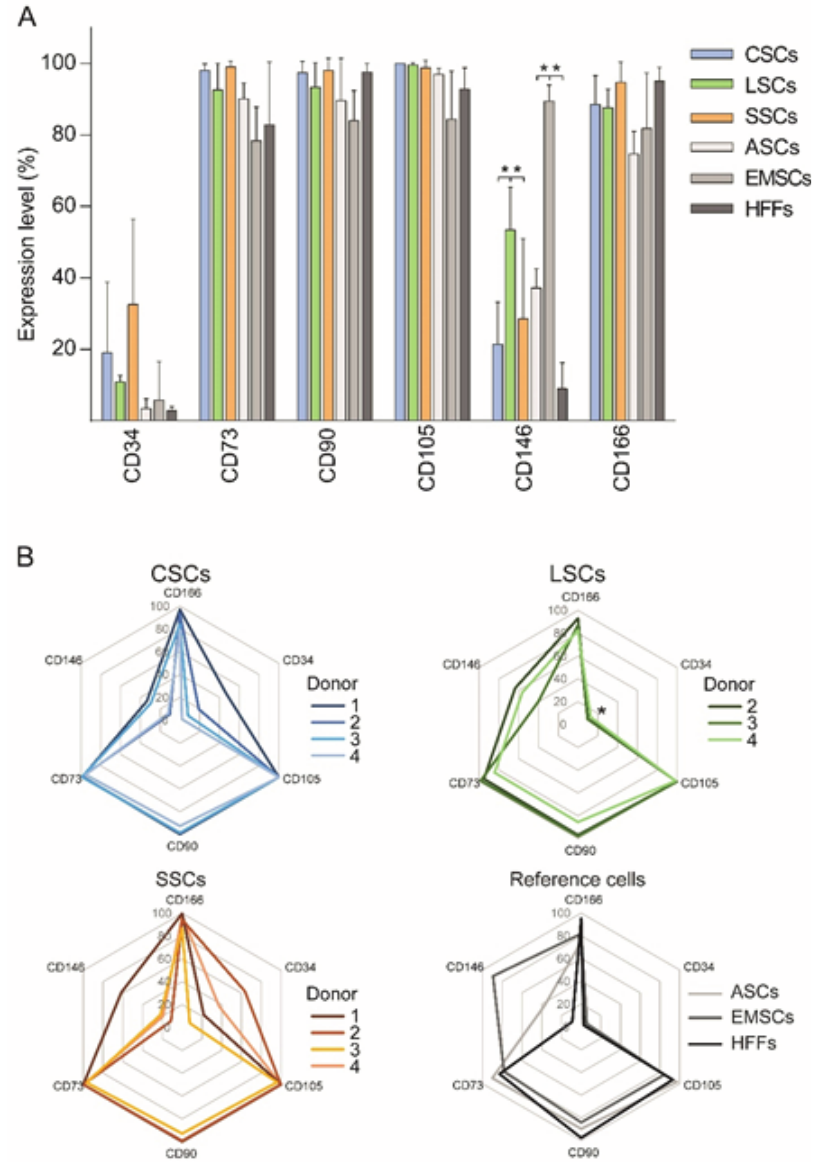
Figure 2. Immunophenotypical profiles of human ocular surface stromal cells with reference to mesenchymal stem cells. (A) Expression levels of single markers. (B) Radar charts indicating inter-donor variability. The data are presented as Means ± SD. The asterisks in panel A indicate a statistically significant ( p < 0.05) difference between the means, and the asterisk in panel B denotes a significantly lower variability ( p < 0.05) of the CD34 in the LSC group as compared to the CSCs and SSCs. N = 4 for CSCs and SSCs, and n = 3 for LSCs, ASCs, EMSCs, and HFFs. CSCs, corneal stromal cells; LSCs, limbal stromal cells; SSCs, scleral stromal cells; ASCs, adipose-derived stem cells; EMSCs, endometrial mesenchymal stem cells; HFFs, human foreskin